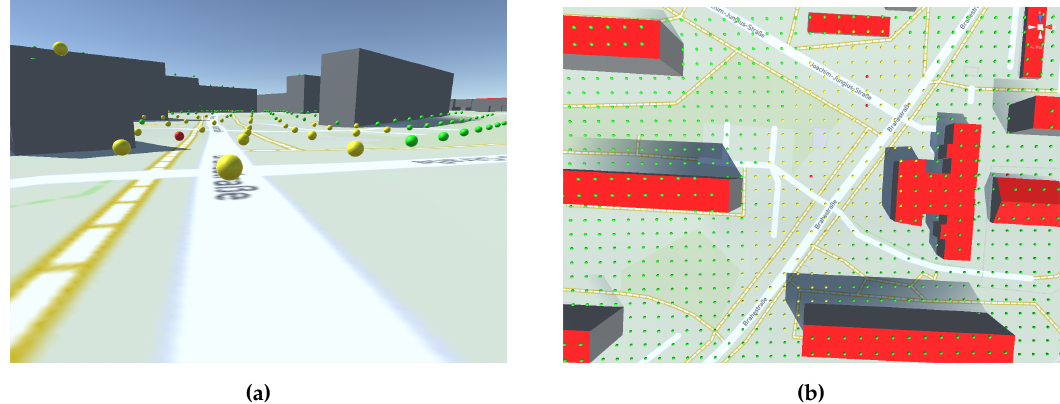
Figure 4. ( a ) View on the noise grid from the user’s perspective; ( b ) top–down view on the noise